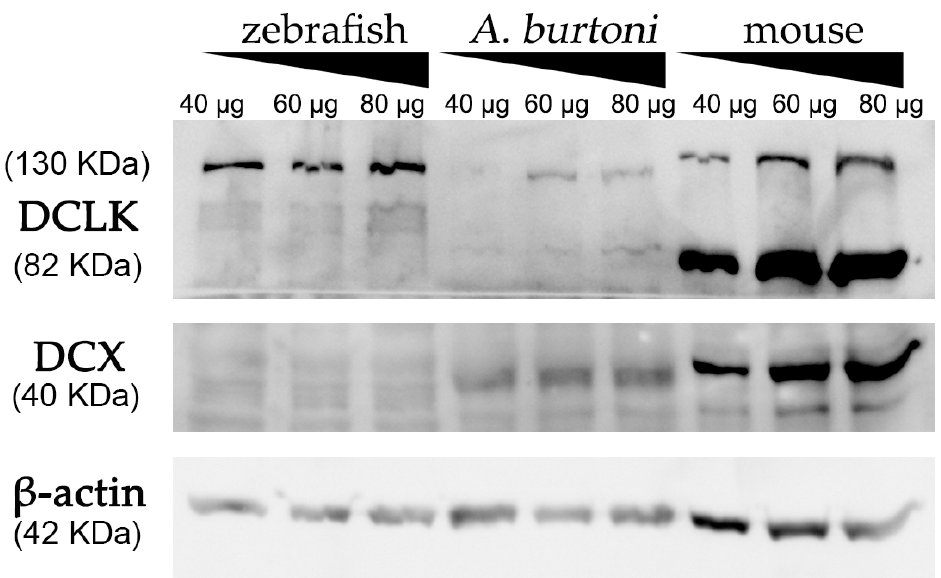
Figure 2. Western blot analysis of protein extracts derived from zebrafish, A. burtoni , and mice brains. Increasing concentrations of proteins were loaded in each well (40, 60 and 80 µ g per well). Analysis shows the expression of DCX in A. burtoni and mice, but not in zebrafish extracts. β -actin was used as the loading control after the membrane stripping.